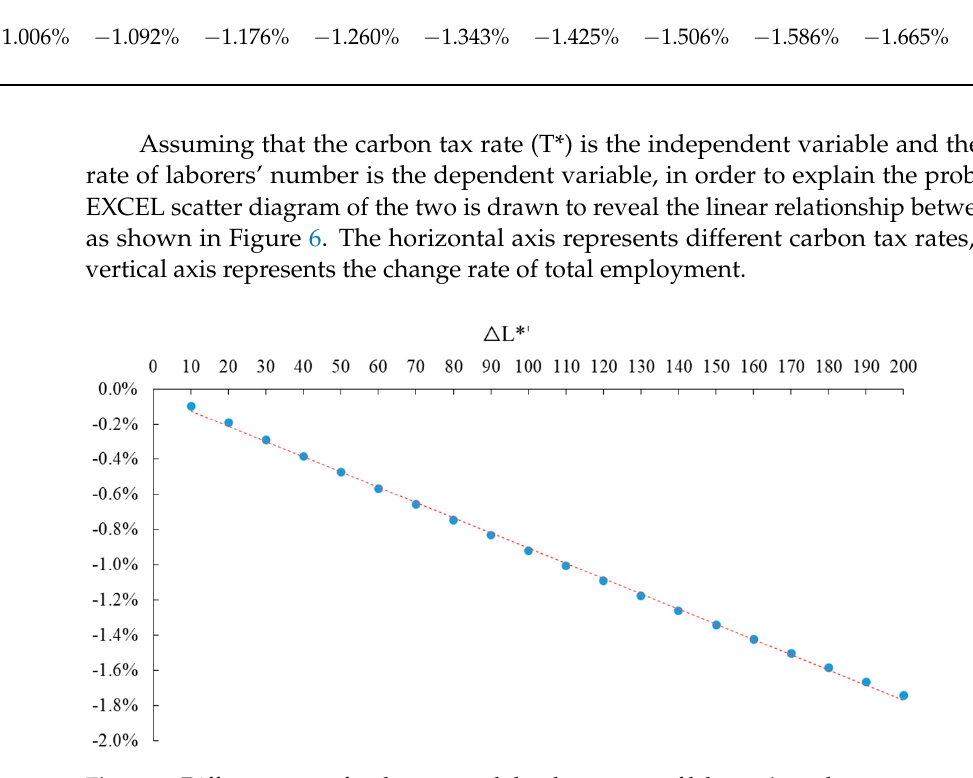
Figure 6. Different rates of carbon tax and the change rate of laborers’ number.